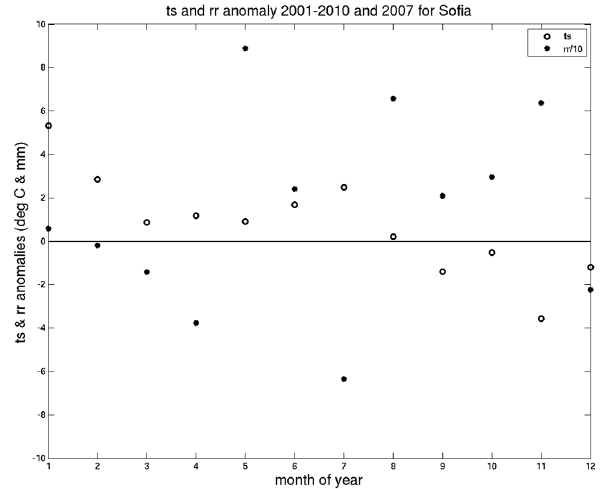
Figure 8. Monthly anomaly of temperature (open circles) and pre- cipitation (filled circles) for Sofia,